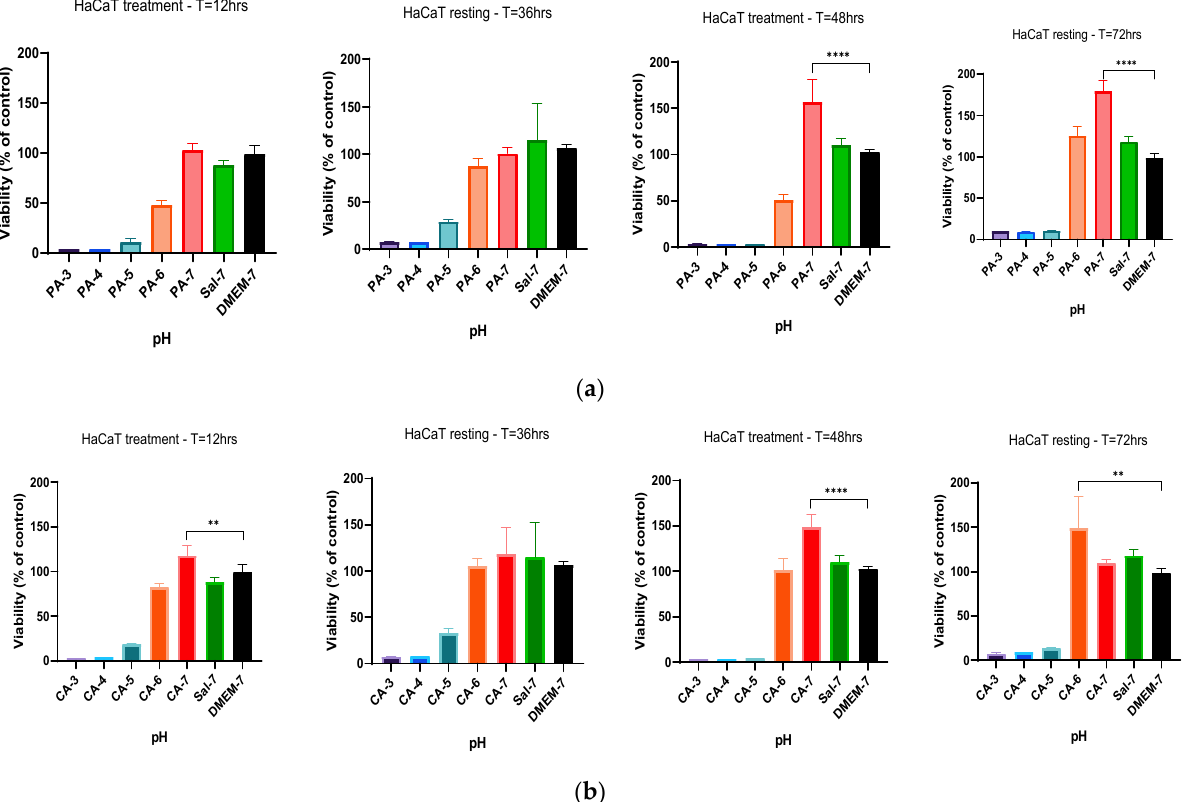
Figure 4. Percentage viability of HaCaT keratinocytes at different time points when treated with ( a ) 0.01 M phosphoric acid (PA) and ( b ) citric acid (CA) buffers, with pH adjusted to 3, 4, 5, 6 and 7. Each bar represents the mean ± standard deviation. * p < 0.05, ** p < 0.01 , ***p < 0.005 and ****p < 0.001 indicates that the results obtained were statistically significant from those of the control group (DMEM-7 ).